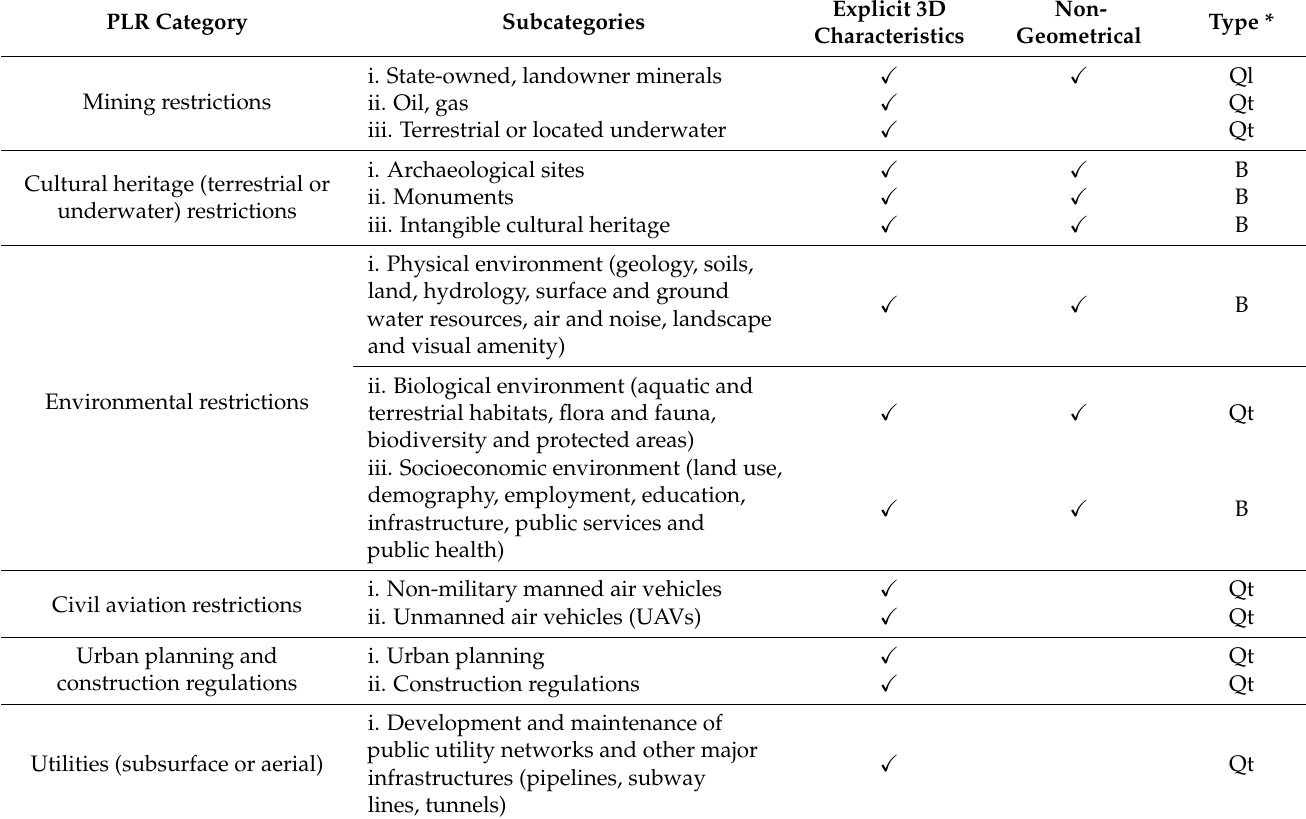
Table 1. Thematic classification of 3D PLRs